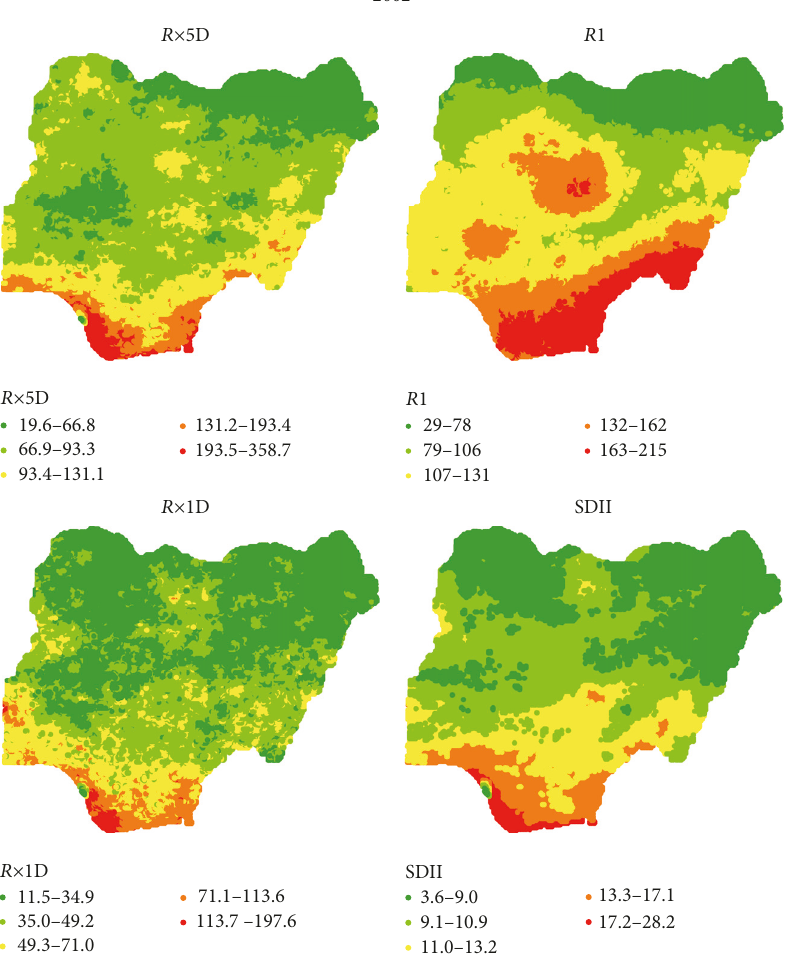
Figure 3: Data posting of indices values from